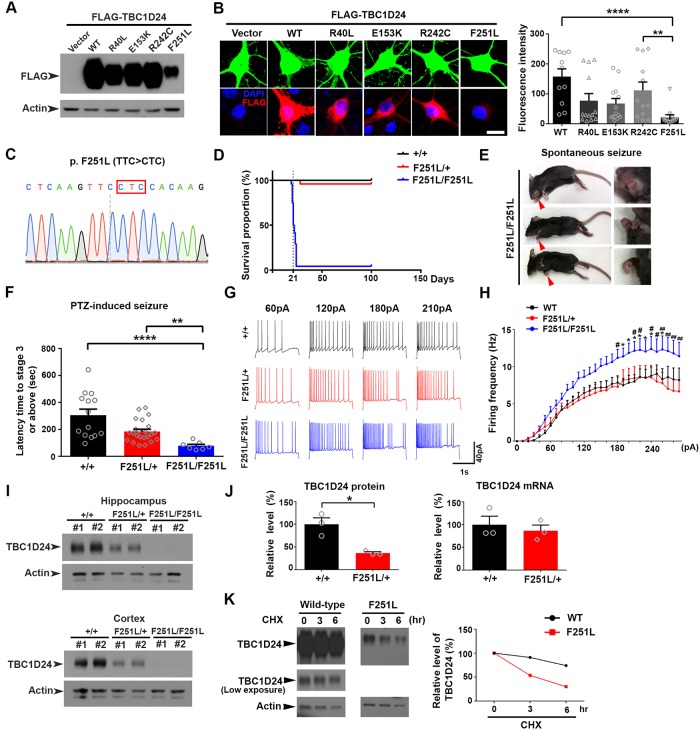
Epilepsy- and ID-associated F251L mutation represses TBC1D24 protein expression and causes spontaneous seizure.(A) HEK 293T cells were transfected with wild-type (WT) or four different disease-associated TBC1D24 mutants. Western blot revealed drastic reduction of TBC1D24 protein expression in cells expressing the F251L mutant. (B) Hippocampal neurons were transfected with GFP together with FLAG-tagged wild-type or four different disease-associated TBC1D24 mutants, followed by immunostaining with antibodies against GFP and FLAG. Quantification demonstrated lowest expression of the TBC1D24-F251L mutant (11–13 neurons were quantified for each group; mean+SEM; **p<0.01, ****p<0.0001; Kruskal-Wallis test followed by Dunn’s multiple comparisons). Scale bar: 10 μm. (C) The nucleotide substitution of the F251L homozygous knock-in mouse was confirmed by Sanger sequencing. (D) The cumulative survival rate was plotted against age for wild-type and mutant mice. (n = 8 for wild type; n = 24 for heterozygous TBC1D24F251L/+; n = 24 for homozygous TBC1D24F251L/F251L mice). (E) Images of carcasses of homozygous TBC1D24F251L/F251L mice that showed signs of maximal seizure (extended tongue and clenched forepaws). (F) The homozygous TBC1D24F251L/F251L mice had significantly reduced threshold of PTZ-induced seizure as compared to wild-type and heterozygous mice. Injection of PTZ was performed on mice at postnatal day 18–20 (n = 14 for TBC1D24+/+ mice; n = 23 for TBC1D24F251L/+ mice; n = 7 for TBC1D24F251L/F251L mice; mean+SEM; **p<0.01; ****p<0.0001;Kruskal-Wallis test followed by Dunn’s multiple comparisons). (G-H) Representative traces of action potential from wild-type, heterozygous TBC1D24F251L/+, and homozygous TBC1D24F251L/F251L CA1 neurons injected with different currents. The frequency of action potential was significantly increased in CA1 neurons from homozygous TBC1D24F251L/F251L mice (16 cells from 4 wild-type mice; 14 cells from 3 heterozygous TBC1D24F251L/+ mice; 16 cells from 4 homozygous TBC1D24F251L/F251L mice; *p<0.05, wild-type vs F251L homozygous; #p<0.05, ##p<0.01, F251L heterozygous vs F251L homozygous; two-way ANOVA followed by Sidak analysis; current F (29, 1290) = 31.19; P < 0.0001; genotype F (2, 1290) = 59.35, P < 0.0001; interaction F (58, 1290) = 0.6470, P = 0.9817). (I) Western blot analysis showed dosage-dependent reduction of TBC1D24 protein expression in the hippocampus and cortex of heterozygous TBC1D24F251L/+ and homozygous TBC1D24F251L/F251L mice (postnatal day 21). (J) Real time RT-PCR showed similar expression of Tbc1d24 mRNA between the hippocampi of wild-type TBC1D24+/+ and TBC1D24F251L/+ mice (postnatal day 42–44) despite the significant difference in TBC1D24 protein expression. (n = 3 mice for each group; mean+SEM; *p<0.05; unpaired Student’s t-test). (K) Increased turnover of the F251L mutant of TBC1D24. HEK-293T cells were transfected with wild-type (WT) or TBC1D24 F251L mutant. The cells were then treated with cycloheximide (CHX, 20 μg/ml) for 0, 3, 6 hr, respectively. Presented values were the signal intensities of TBC1D24 in Western blot. Lower exposure for wild-type TBC1D24 was shown in parallel to show its relatively stable expression without saturating the signals.